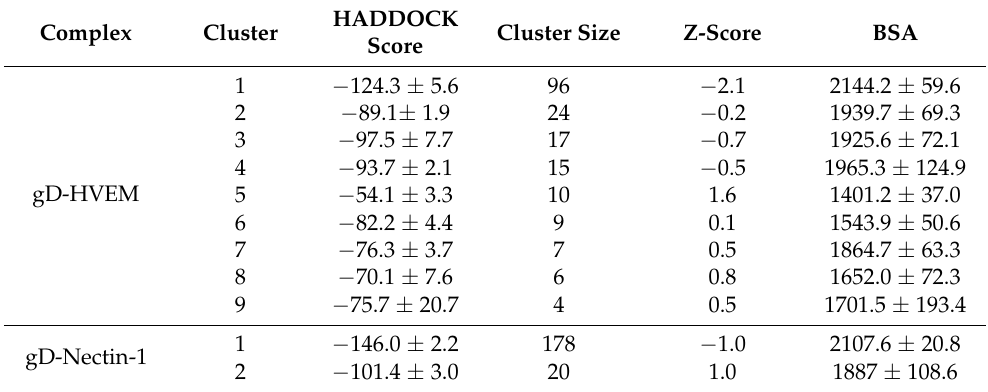
The best clusters (the lowest in energy) were analysed in terms of interactions using Maestro graphical user interface (Figure 2) and were aligned to the experimental structures through the Protein Structure Alignment tool.